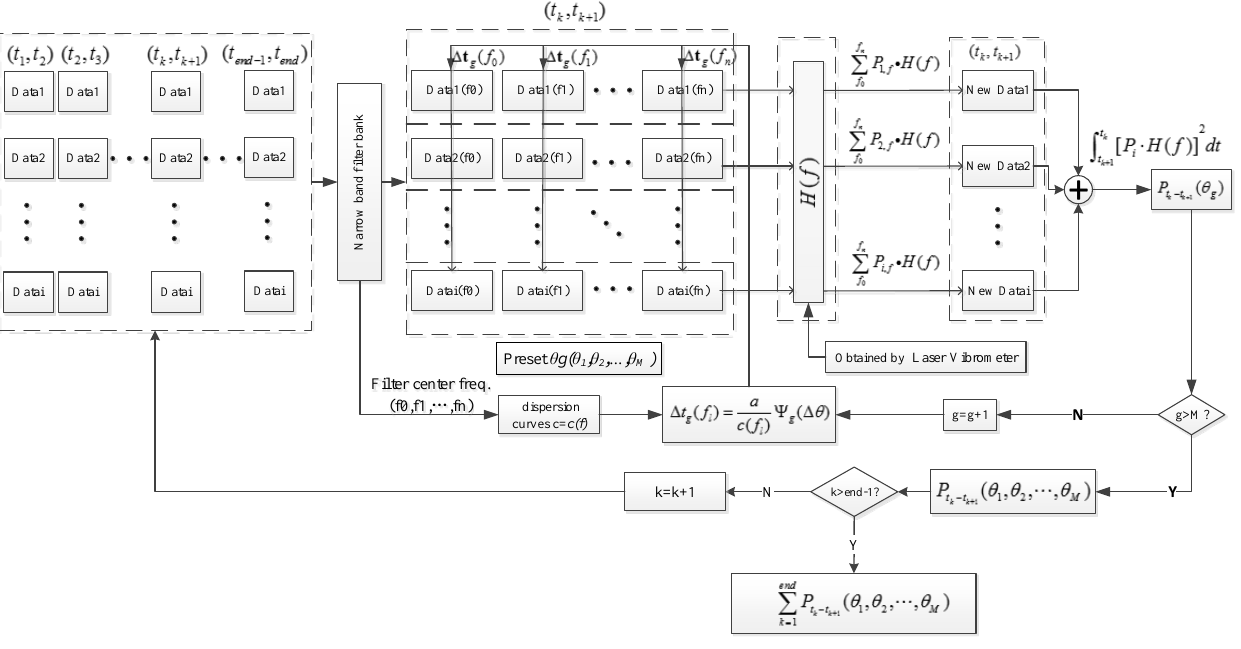
Figure 5. Algorithm flow